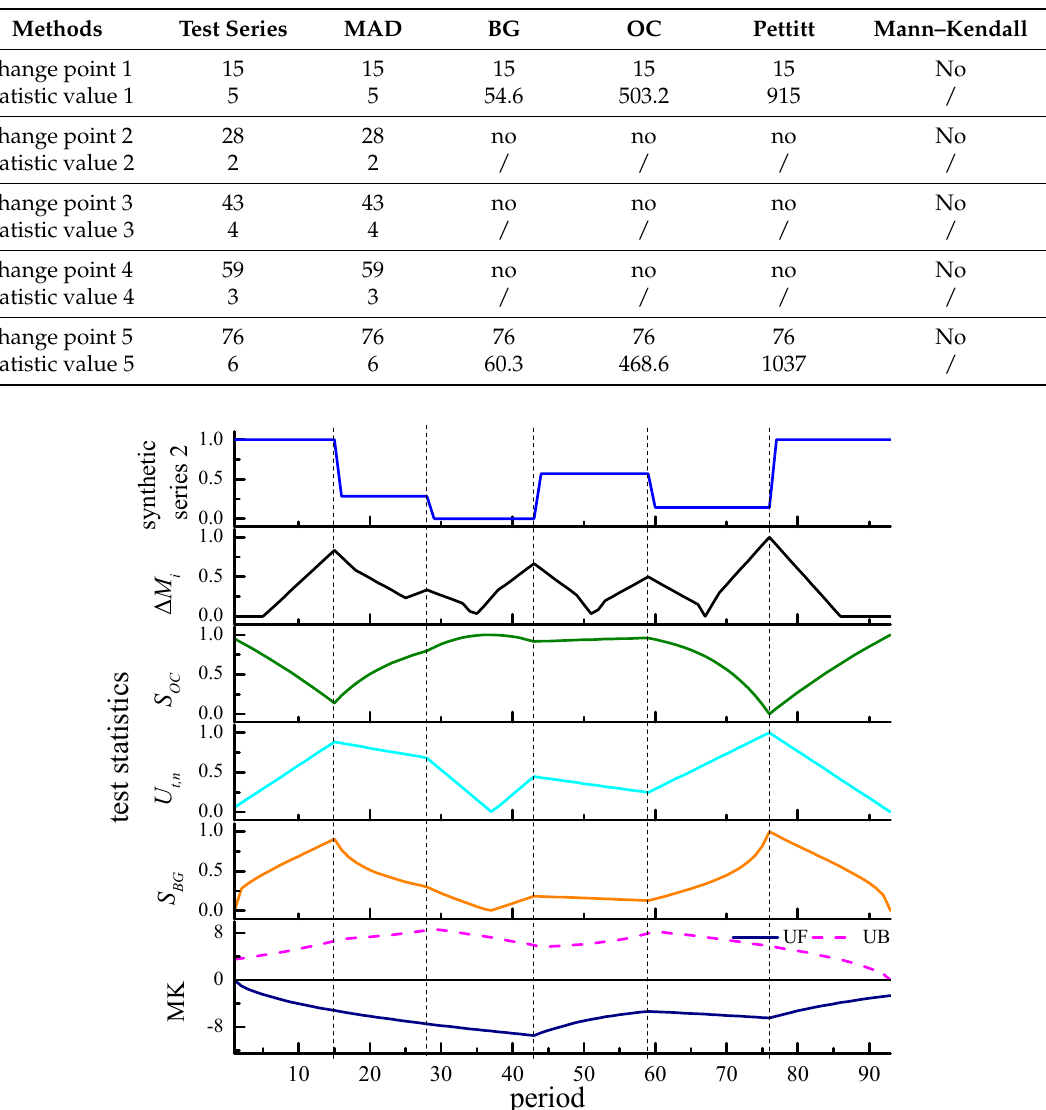
Table 3. Detecting results of multi-mutation points series without errors.